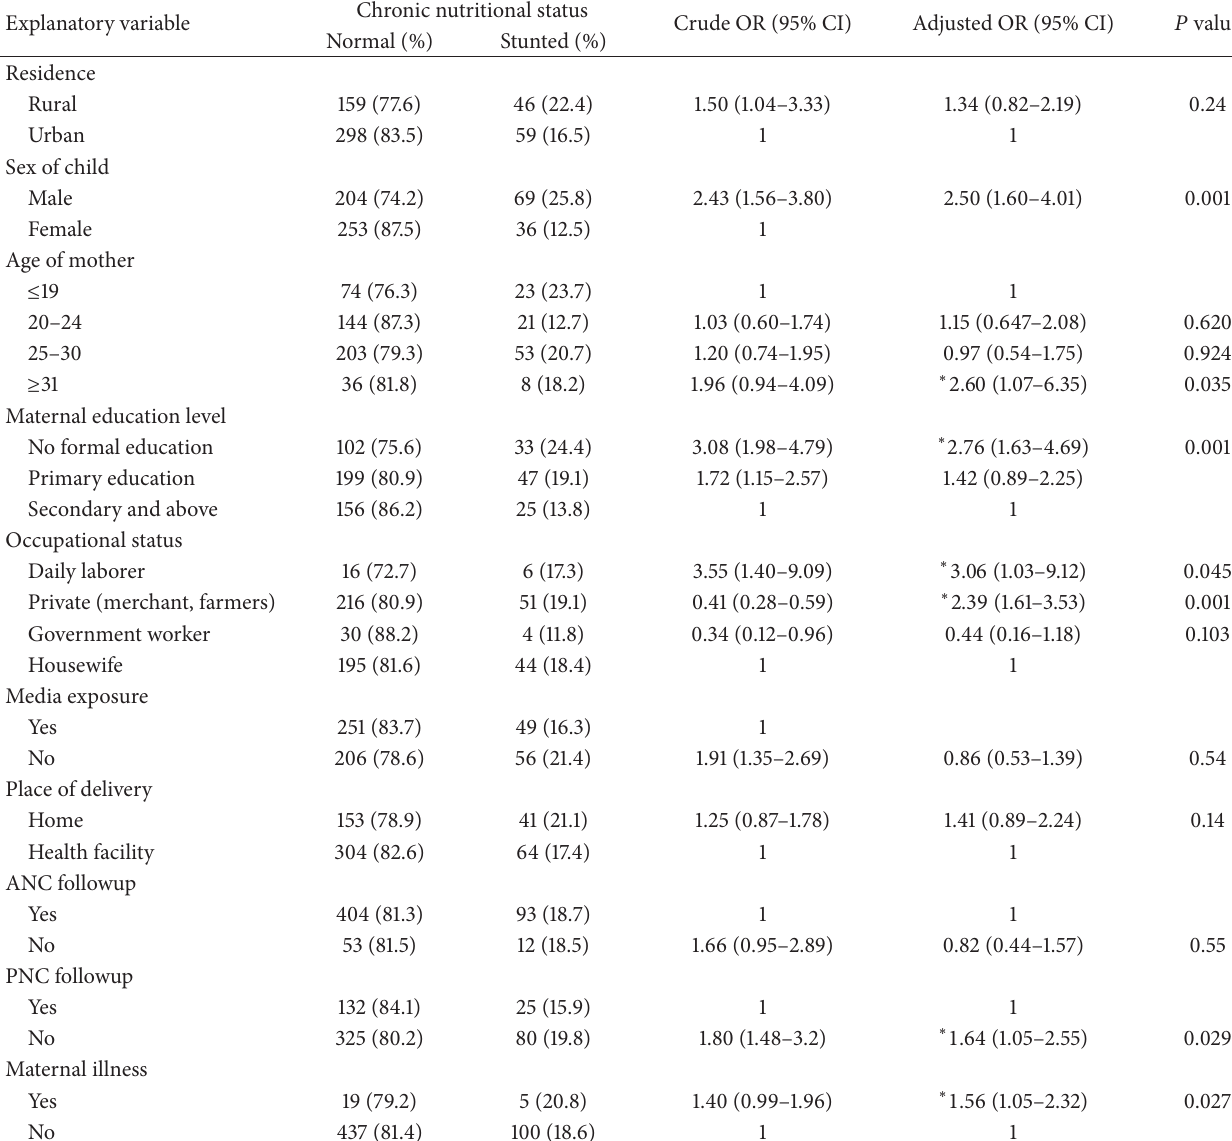
Table 2: Factors associated with stunting among mothers who have 6–23 months of young child in Kemba Woreda in 2014/15. Explanatory